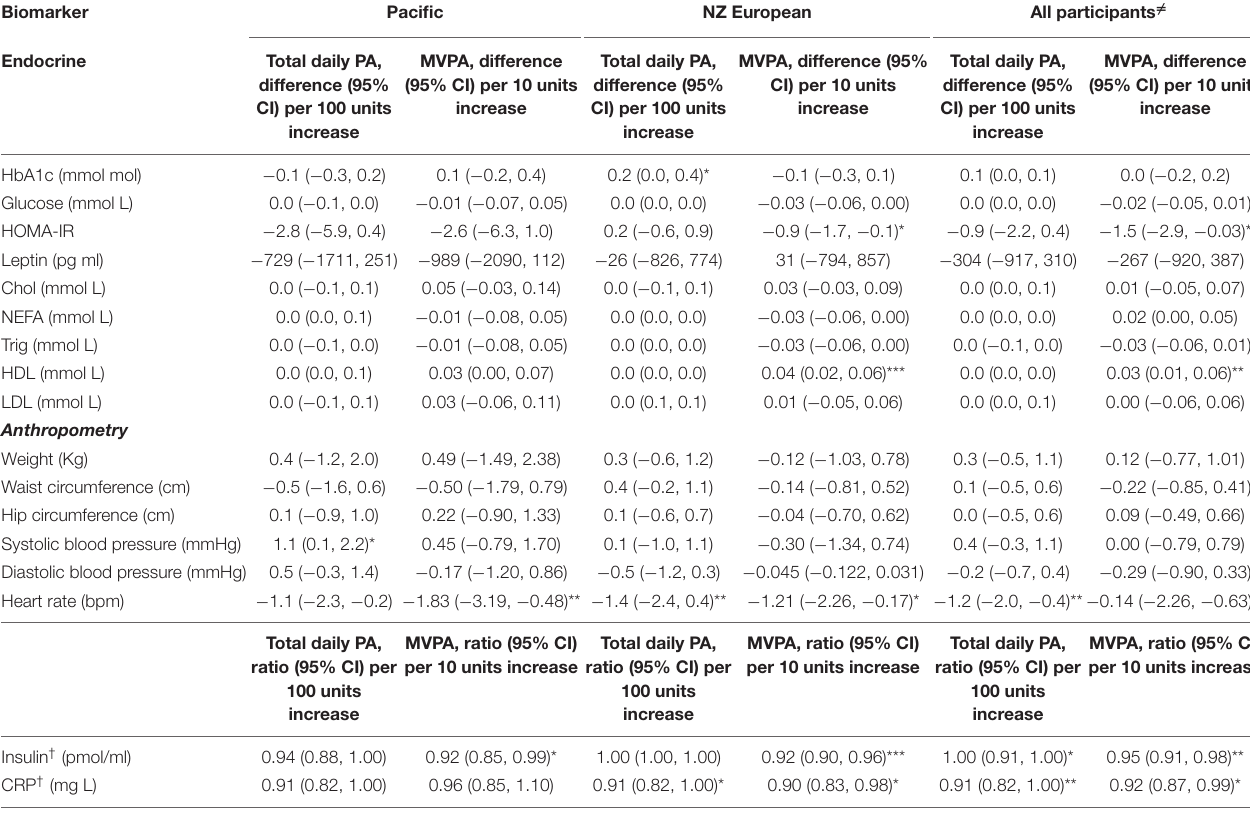
TABLE 3 | Association between total daily PA (cpm) and MVPA (min/day) and metabolic health markers. Biomarker Pacific NZ European All participants